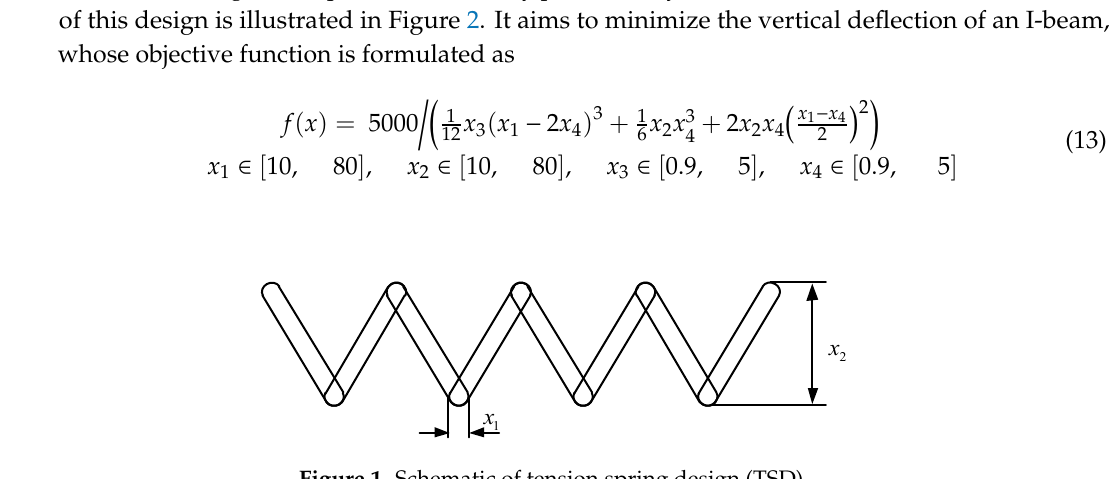
Figure 1. Schematic of tension spring design (TSD).